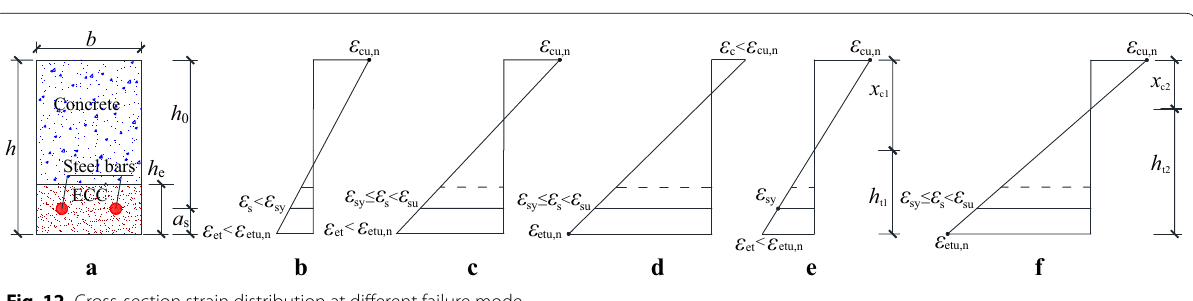
width of cross-section, h e is the height of ECC, a s is the ε s < ε sy , ε et < ε etu,n , as shown in Fig. 12b. ② Compres- vertical distance between the cross-section bottom edge sive failure 2 after yielding of steel: ε c ε cu,n , ε sy ε s < ε su , = ≤ and the centroid of steel bars, h 0 is the effective height of ε et < ε etu,n , as shown in Fig. 12c. ③ Tensile failure: ε c < ε cu,n , cross-section, h 0 h – a s . h t is the tensile height (neutral ε s < ε su , ε et ε etu,n , as shown in Fig. 12d. Where ε et is the = = axis depth) of cross-section, x c is the compressive height ECC bottom tensile strain, ε s is the steel bars tensile (above the neutral axis) of cross-section. strain, ε c and ε ct are the concrete maximum compressive and tensile strain, respectively. h and b are the height and